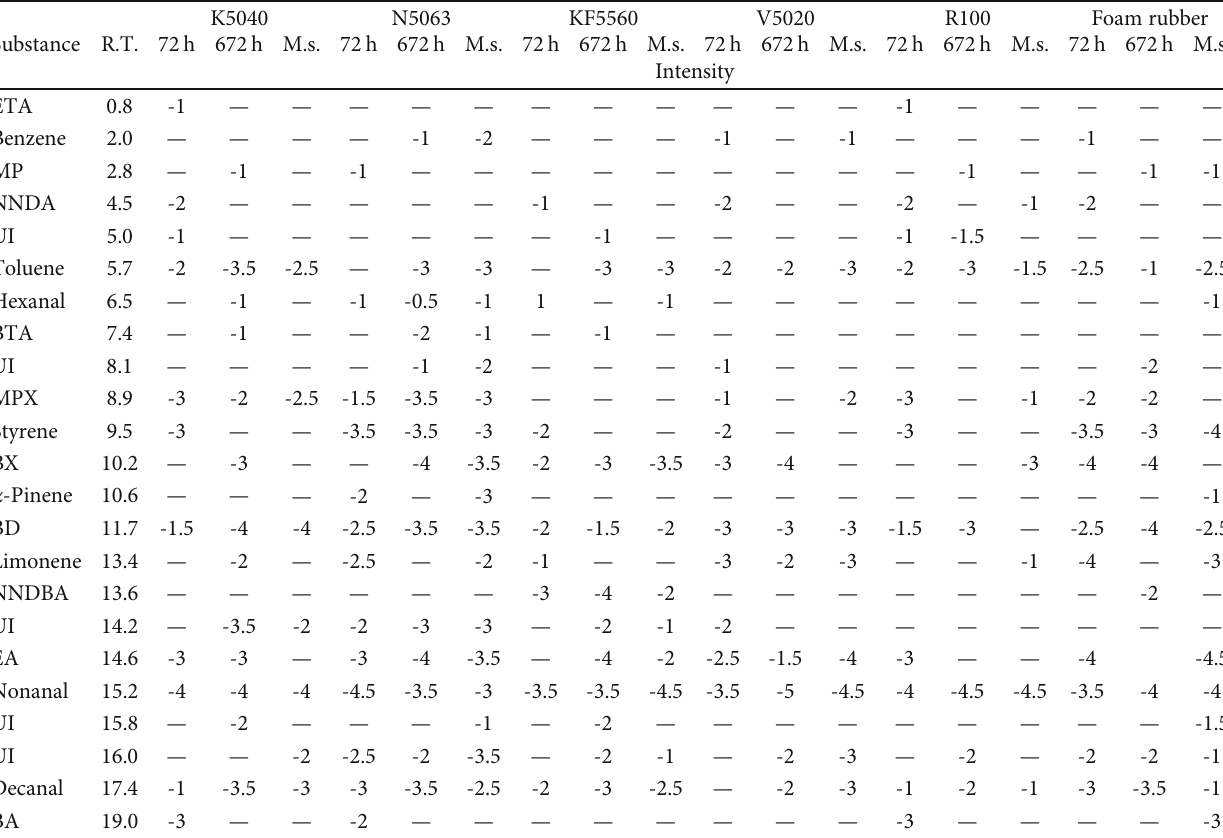
Table 4: Results of the olfactory assessment of polymeric foam materials. Substance R.T.